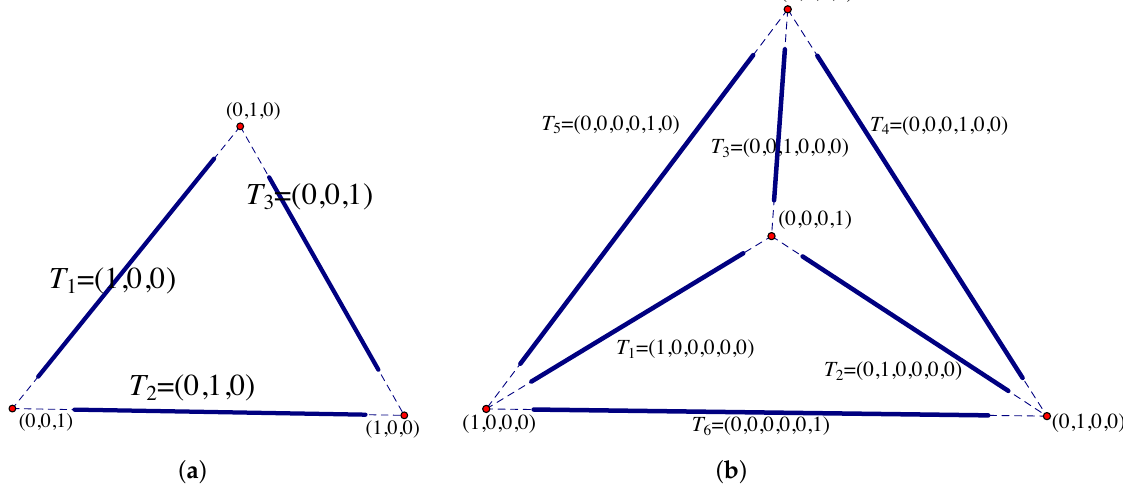
Figure 44. Trees on the edges of a d -simplex, for d = 2 ( a ) and d = 3 ( b ). The vertices have projective coordinates and the edges are given in Plücker